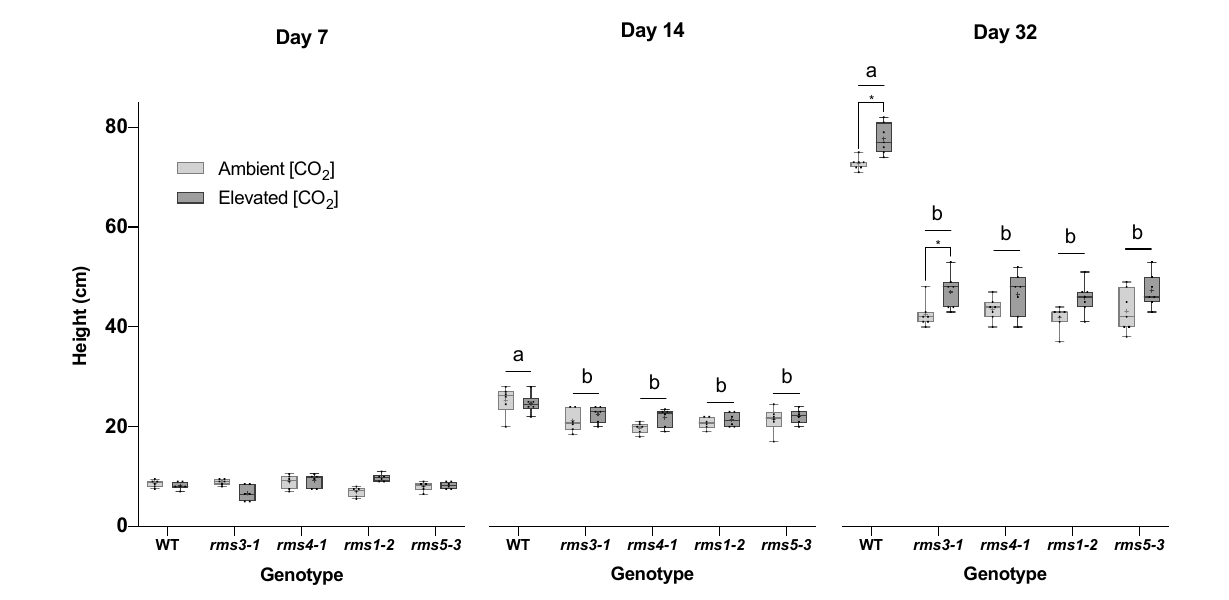
Figure 1. The effect of high CO 2 on plant height in wild type peas and mutants defective either in strigolactone (SL) synthesis ( rms1 - 2 and rms5-3 ) or signaling ( rms3 - 1 and rms4-1 ). Plants were grown for up to 32 days either under ambient (420 ppm) or high CO 2 (750 ppm). Different letters indicate a statistically significant difference ( p < 0.05) between genotype at each time point, while a significant difference between [CO 2 ] within genotype is indicated by an asterisk ( p < 0.05). Day 7 and day 14, n = 6; day 32, n = 7. Mean indicated as +.